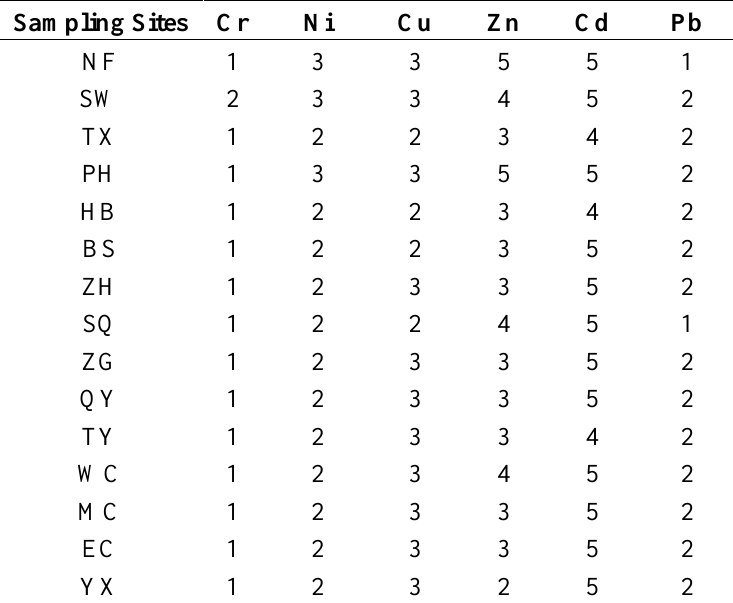
Table 4. Potential ecological risk classes based on